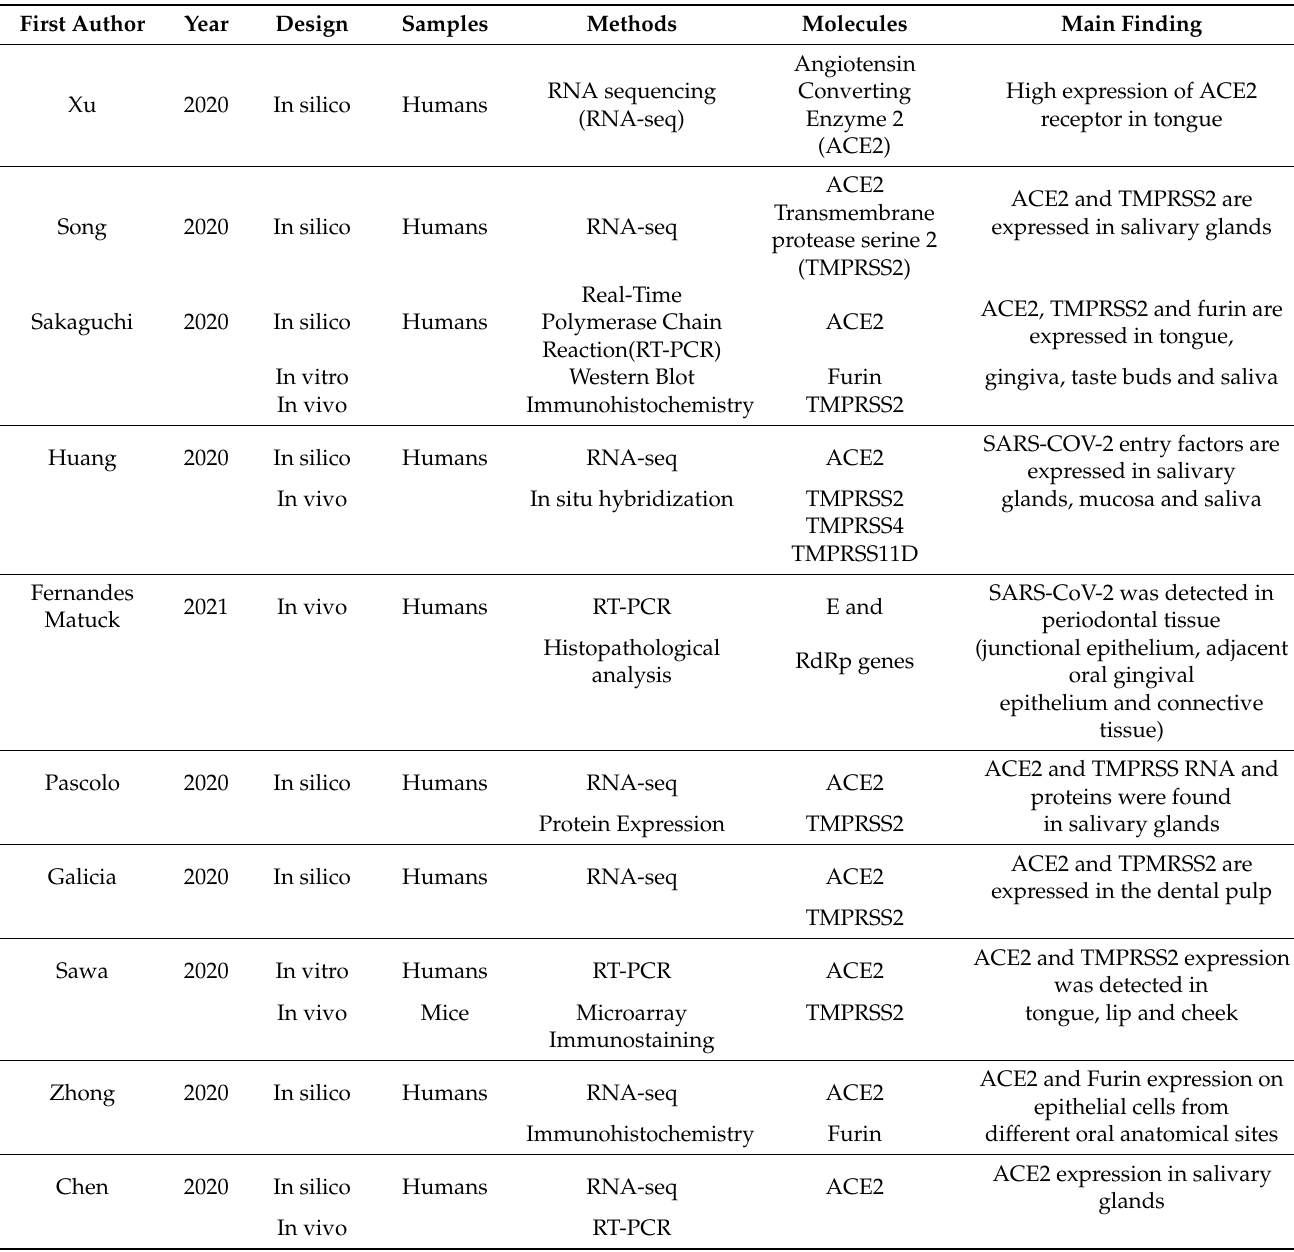
Table 1. Studies that report the presence of the molecules responsible for the severe acute respiratory syndrome coronavirus 2 (SARS-CoV-2) infection in oral tissues and